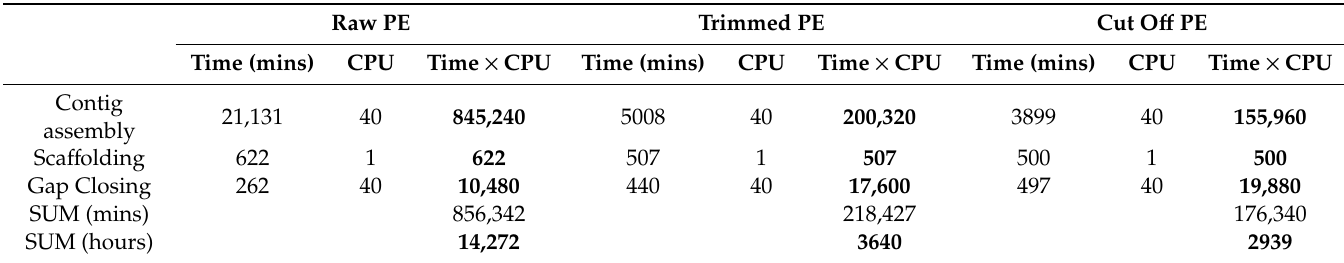
Table 3. Computational times for genome assembly based on three datasets using PLATANUS. The computational times for three genome assembly procedures, contig assembly, sca ff olding, and gap closing, were estimated, separately.